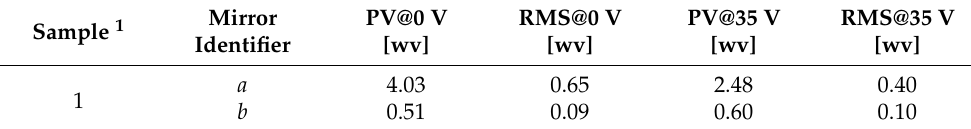
Table 2. Measured Sample 2 mirror sample optical features.